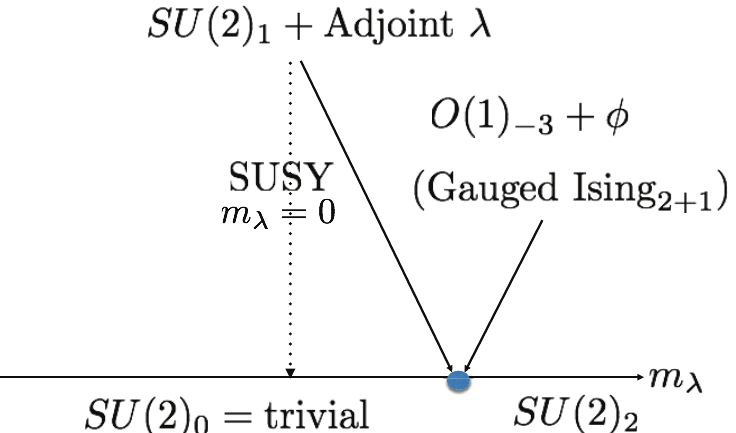
Figure 5: The phase diagram of SU ( 2 ) with an adjoint fermion. Note that the 1 physics at the supersymmetric point is smooth in this example, which corresponds to k = N / 2. We also present the dual description. Since O ( 1 ) ∼ (cid:90) , the dual de- 2 scription of the transition is in terms of the gauged 2 + 1d Ising model with a certain topological term in the (cid:90) gauge 2